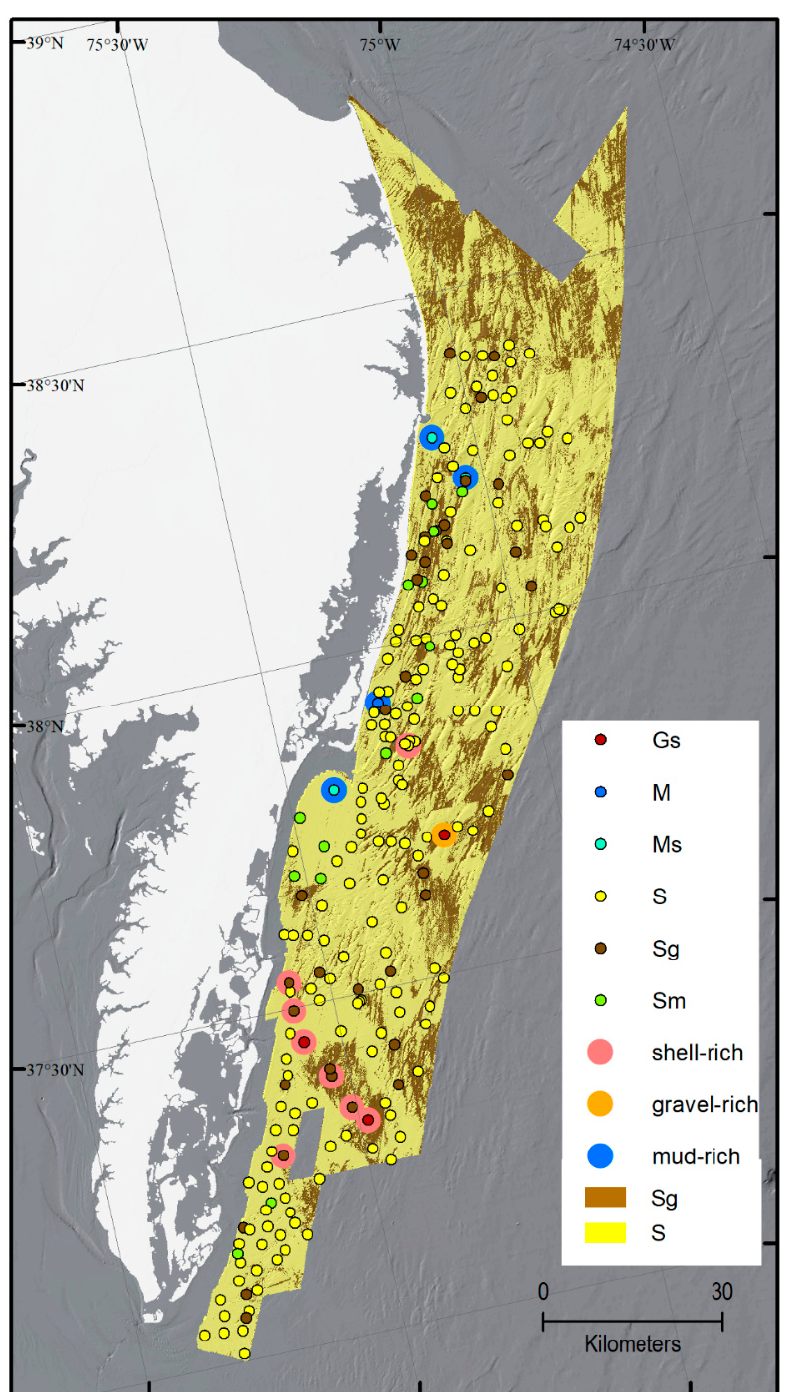
Figure 9. Sediment samples (small circles) overlay a classified sediment texture map derived from the RF classification by combining HBLS and HBSS to create a sand with gravel (Sg) texture class, and combining LBLS and LBSS to create a sand (S) texture class. The small circles are coded by the sample’s Barnhardt texture. Large circles around some samples illustrate where sediment texture is more than 50% shell, gravel, or mud, which differs significantly from the mean sediment texture assigned to the classes.